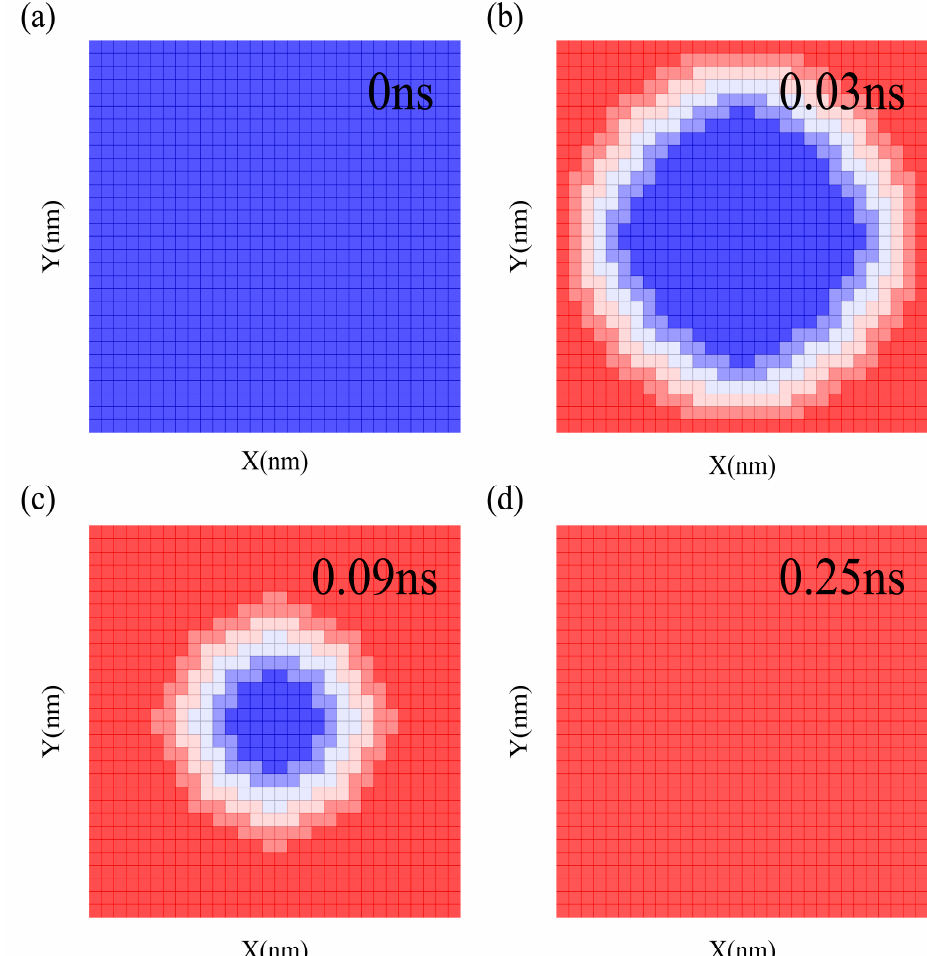
Figure 4. ( a ) The initial 0 ns temperature of the layer of silicon at around 300 K; ( b ) and ( c ) show the temperature distribution of the process in 0.28–0.32 ns and 0.88–0.92 ns; and ( d ) shows the final 0.25 ns temperature of around 350 K.